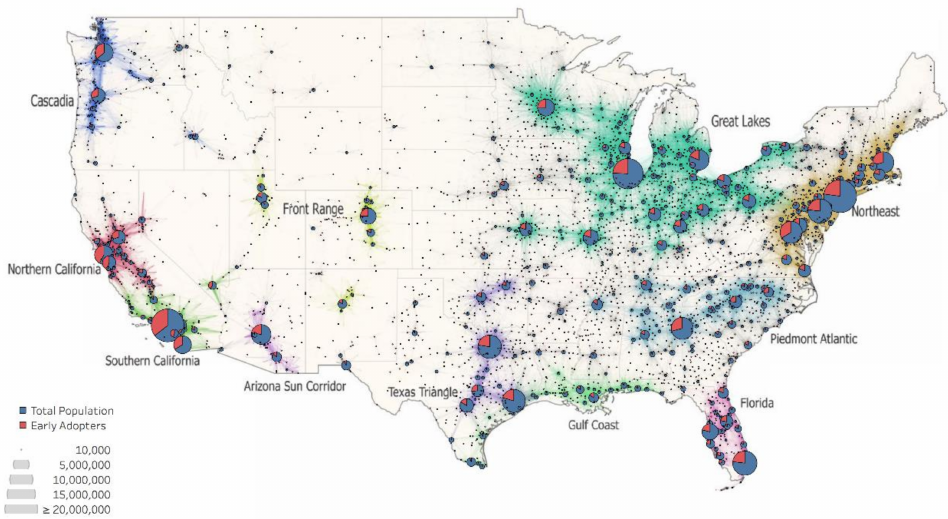
Figure 2. Population and total early adopters metric (EAM) (defined as the fraction of the total EAM for the urban area, normalized to 100 million) per U.S. urban area. Population data taken from U.S. Census Bureau. The mega-regions color-coded in the figure indicate frequency and geographic extent of household vehicle commuting patterns between cities, and are derived from a recent study on travel data